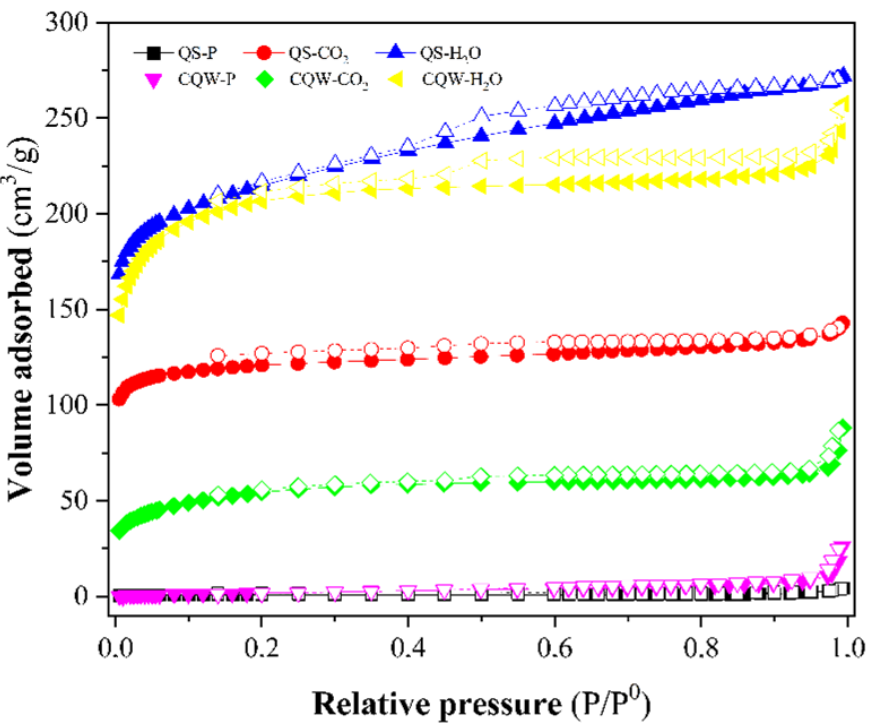
Figure 3. N 2 adsorption-desorption isotherms curves at 196 °C of samples. Closed symbols: N 2 adsorption curve and open symbols: N 2 desorption curve.